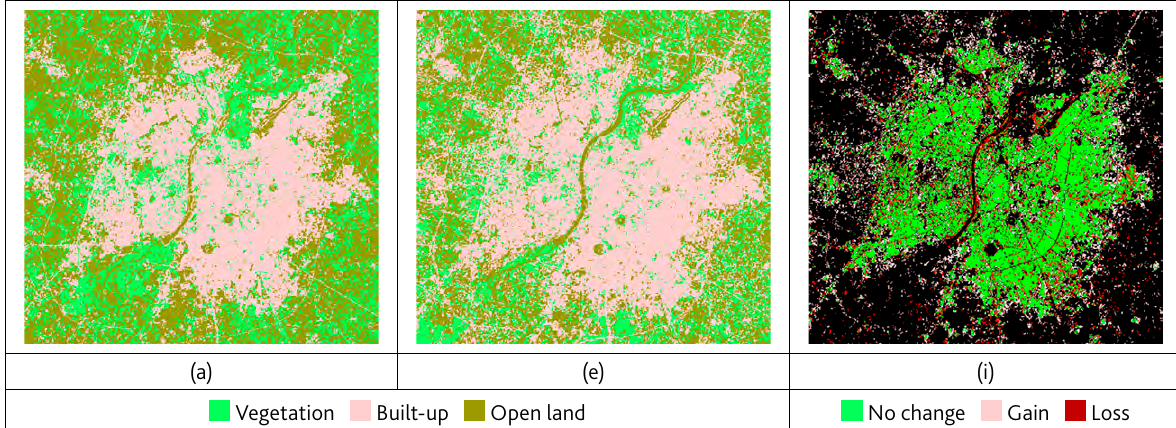
Figure 4. OBCD results using ABETC for Ahmedabad Data set. (a) Classified Image of the year 2011 (b) Classified Image of the year 2020 (c) Built-up area change map of